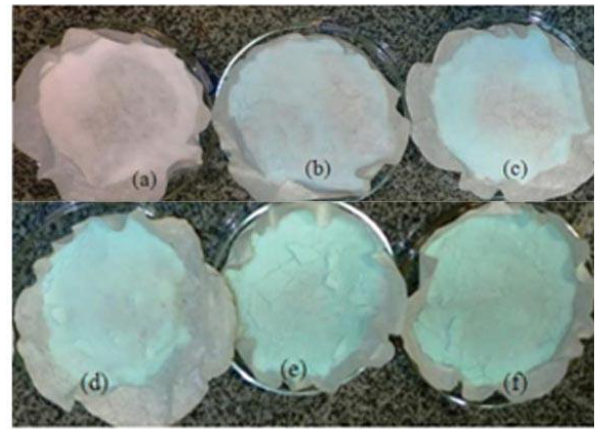
Fig. 1. Appearance and color of (a) silica gel and CuO/SGn nanocomposites with immersion times of (b) 10, (c) 20, (d) 40, (e) 60, and (f) 90 min.